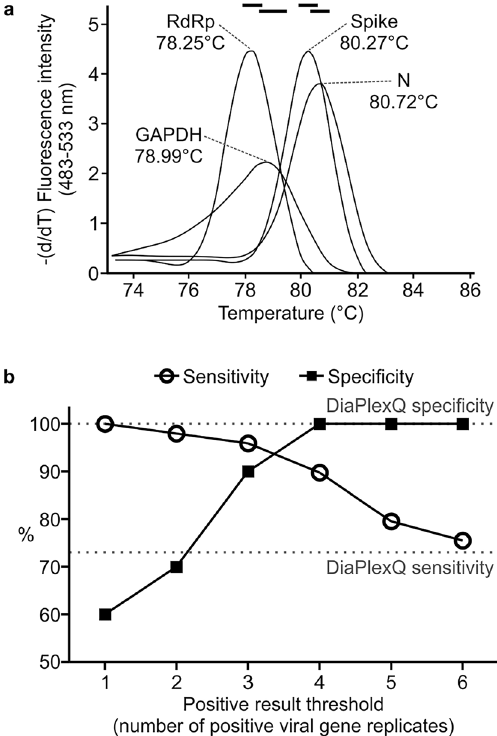
Figure 2. Criteria of the test result assignment. ( a ) Derivatives of the representative melting curves of the tested genes in the screening test and mean Tm values. Black bars on top: temperature intervals within which the measured Tm value is considered specific for each gene. ( b ) Sensitivity and specificity of the seminested SARS- CoV-2 screening test depending on the positive result criterion. The percentage of true positive samples (n = 49) and true negative samples (n = 20) which were qualified correctly depending on the number of positive replicates of viral genes (in total of 6) in the screening test that was chosen as a threshold. Dotted lines: respective parameters, achieved by validated diagnostic